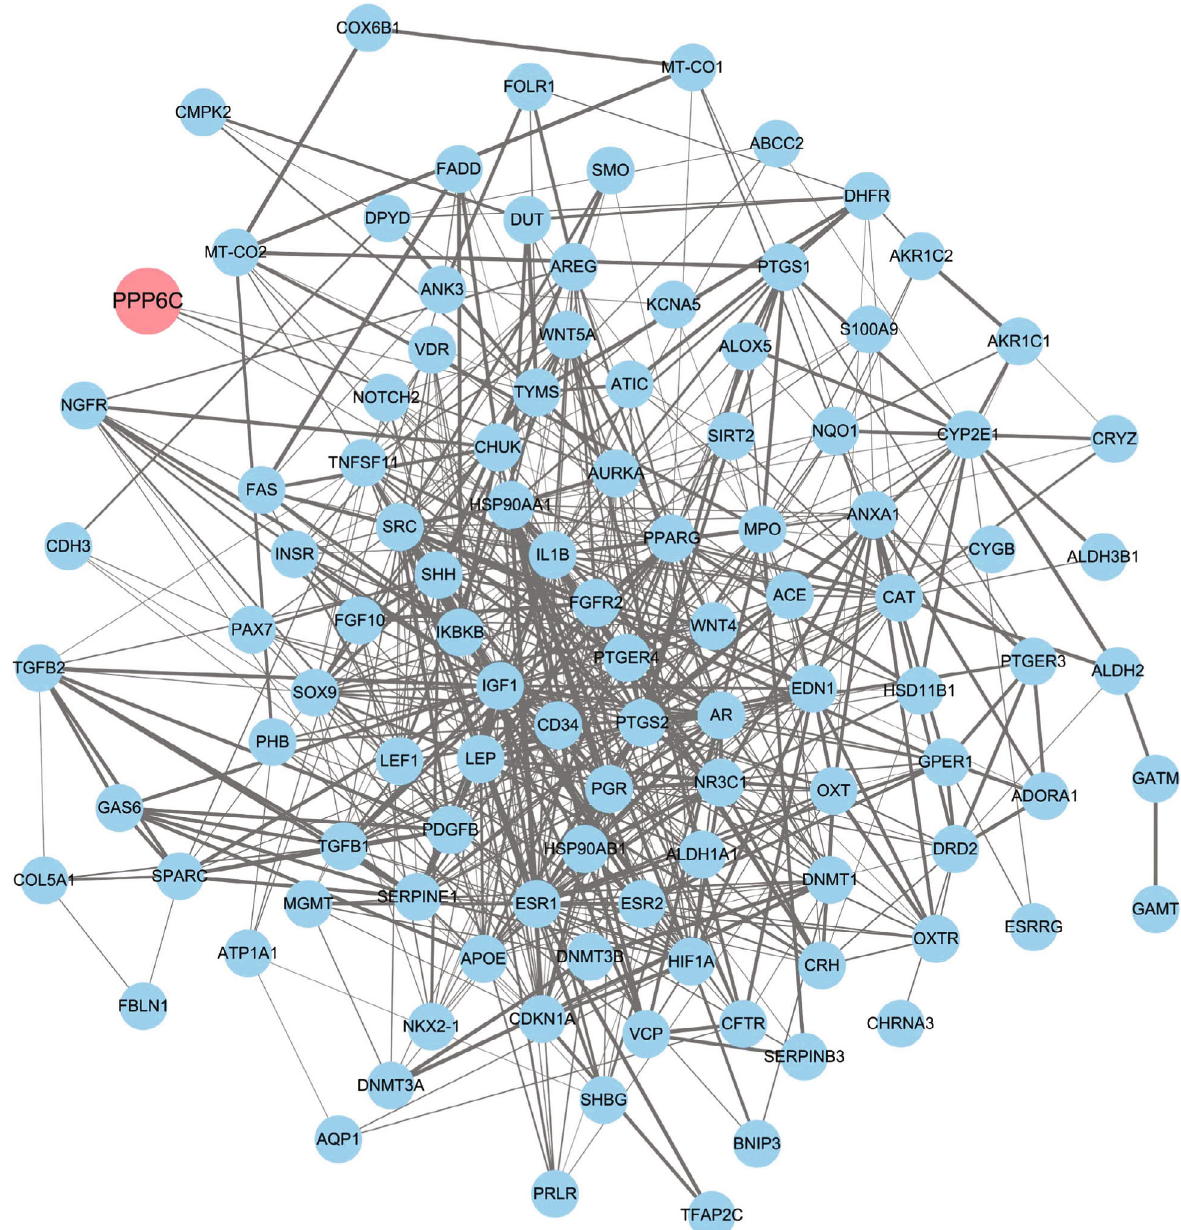
Figure 4: PPI interaction network of cervical cancer target